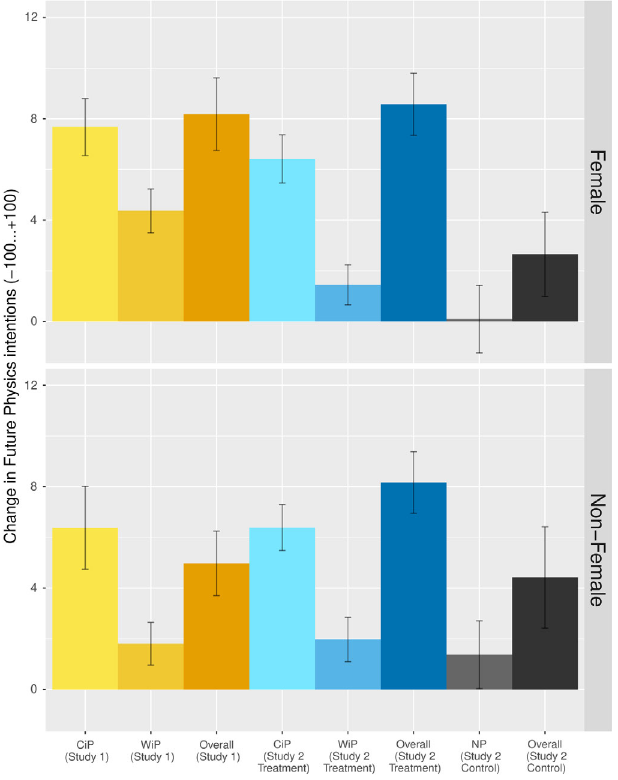
FIG. 4. Summary of results including per-lesson results (Careers in Physics, Women in Physics, and Notable Physicists lessons, in addition to the overall impact on students), MRE- identified students on top, non-MRE identified students on bottom. For each lesson (CiP, WiP, or NP), the bar represents the immediate post- minus immediate prescore. For the overall measure, the bar represents the latest post- minus prescore. Error bars represent standard errors.